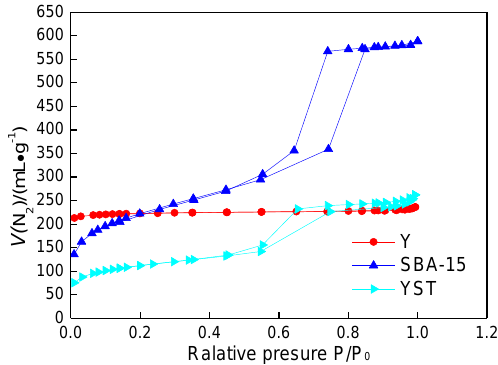
Figure 4. N 2 adsorption-desorption isotherms of Y, SBA-15 and YST.